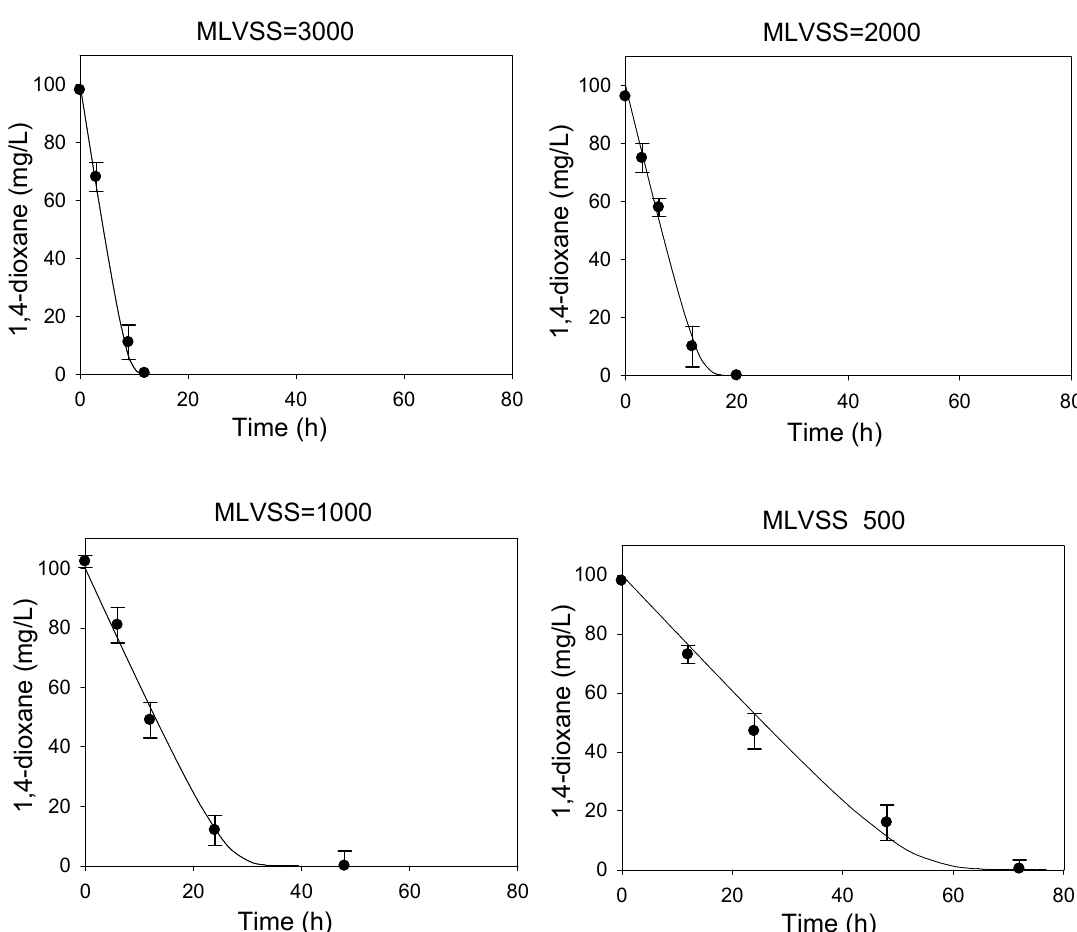
Figure 2. Biodegradation of 1,4-dioxane with varying concentrations (500, 1000, 2000, and 3000 mg / L of mixed liquor volatile suspended solids (MLVSS)) of biomass and model predictions. Error bars represent 1 standard deviation.